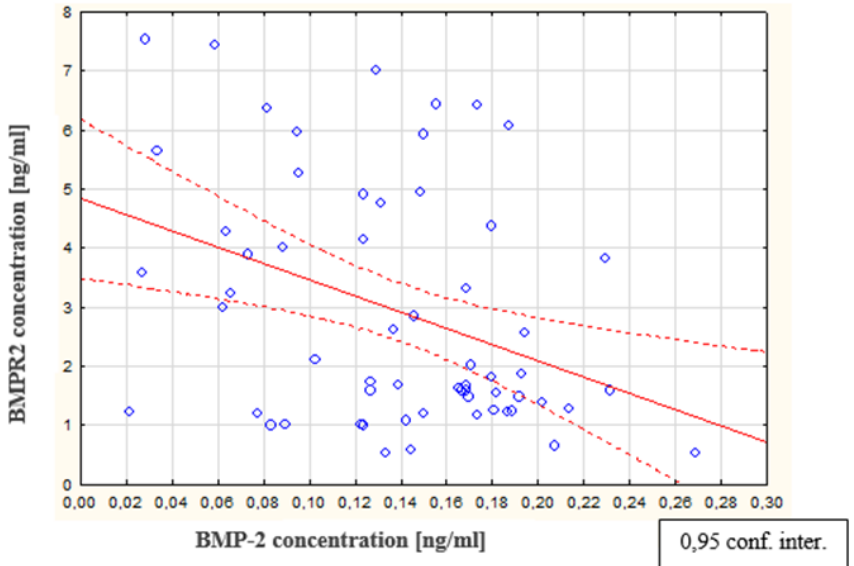
Figure 9. Linear regression curve illustrating the correlation between the concentrations of BMPR2 and BMP-2 in the peritoneal fluid of women with endometriosis.